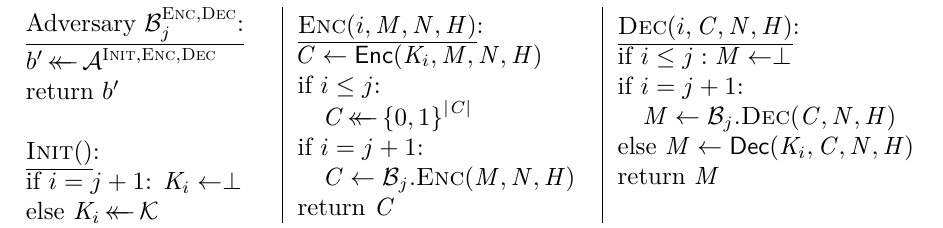
Figure 15: Adversary B in the single-user AE game based on a multi-user AE adversary A